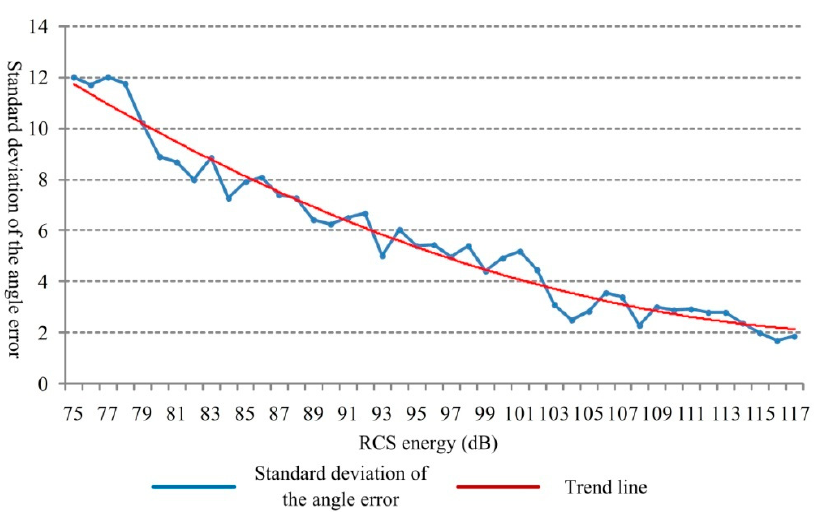
Figure 15. Angle error standard deviation distribution under different RCS energy values.